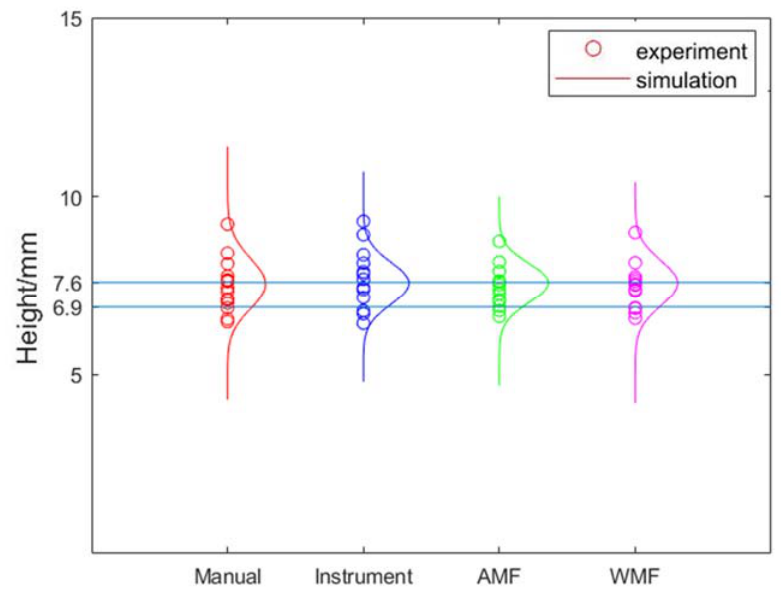
Figure 11. The e ff ect of measuring crack a from top-surface by K2.5 Figure 11. The effect of measuring crack a from top ‐ surface by K2.5 Probe. Figure 11. The effect of measuring crack a from top ‐ surface by K2.5 Probe.